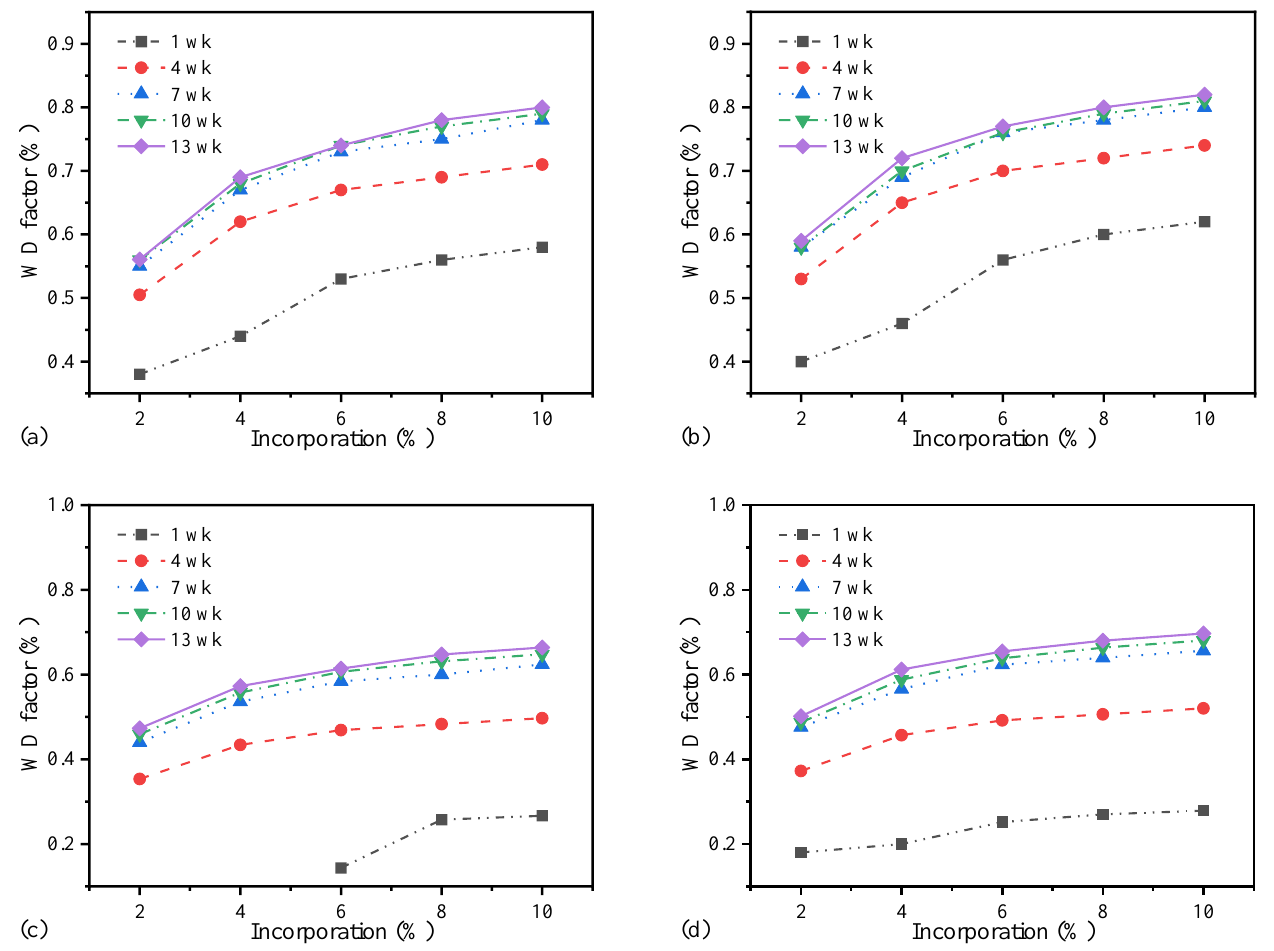
Figure 6. WS factor of ( a ) ISW-improved silt and ( b ) cement-improved silt. WD cycles could deteriorate soil microstructure and incur strength heterogeneity. Study on the WD factor is beneficial to explore the durability of improved silt from another expective. The two kinds of improved silt were subjected to the WD cycle test; the results are exhibited in Figure 7 (specimens with some incorporation that could not withstand three WD cycles are not exhibited).